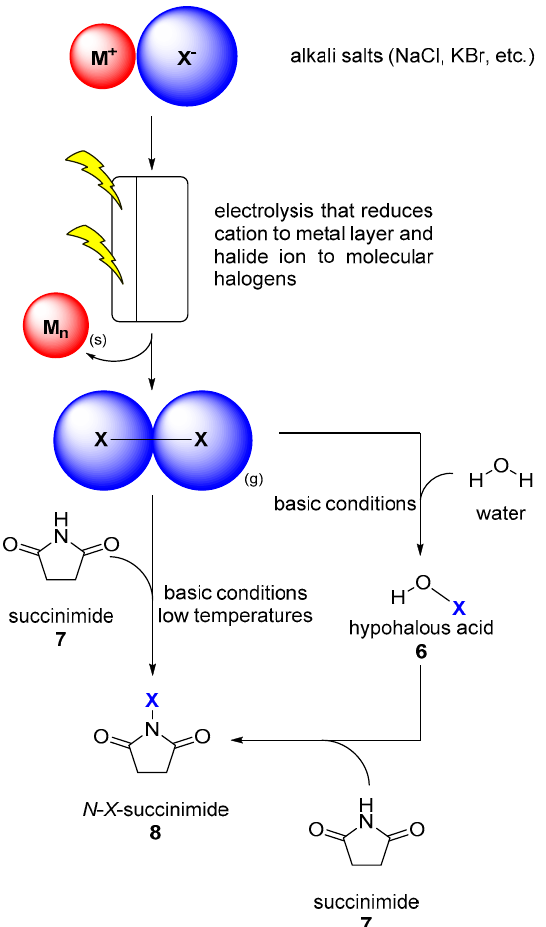
Figure 3. Workflow for the provision of halogenating reagents from alkali salts. The electrolysis process thus produces molecular halogens (X 2 ), as well as hypohalous acids (HOX, 6 ) and N -halogenated succinimides (NXS, 8 ) in further steps.